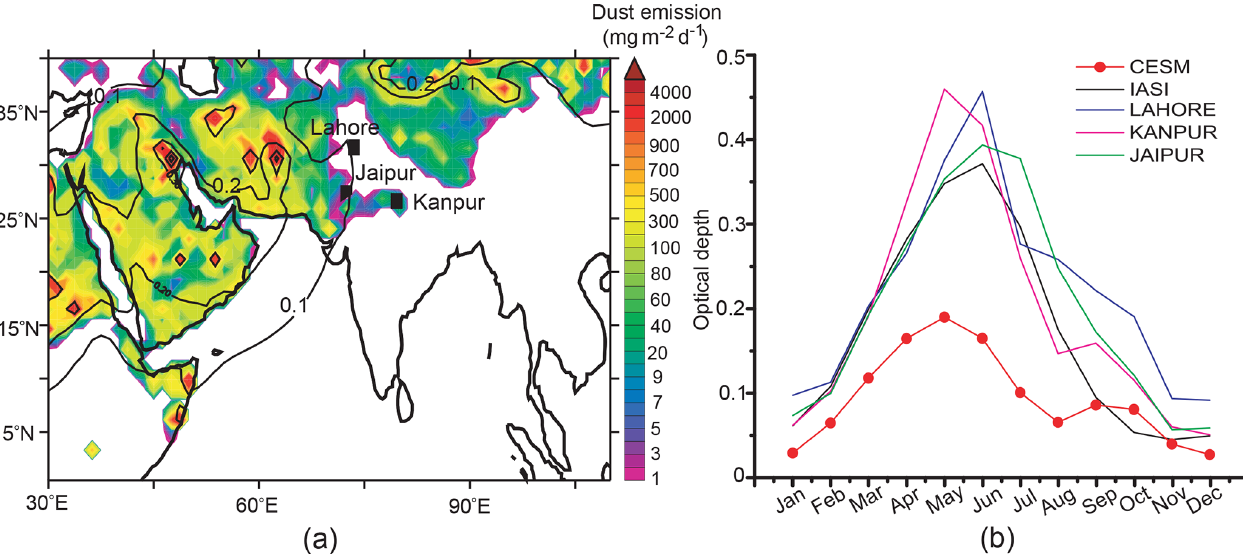
Figure 3. (a) Shading shows the distribution of the main dust-emitting regions from CESM, and the contours indicate the dust optical depth. Both parameters have been averaged for 10 model years. (b) Comparison of the monthly climatology of the dust optical depth over the South Asian dust belt from the CESM Ctrl simulation with IASI and AERONET (Lahore, Kanpur, and Jaipur)